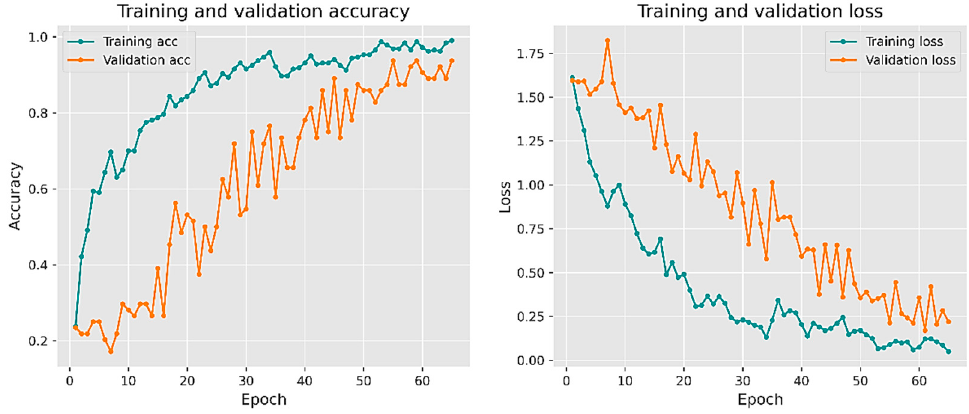
Figure 6. Performance of scratch model.